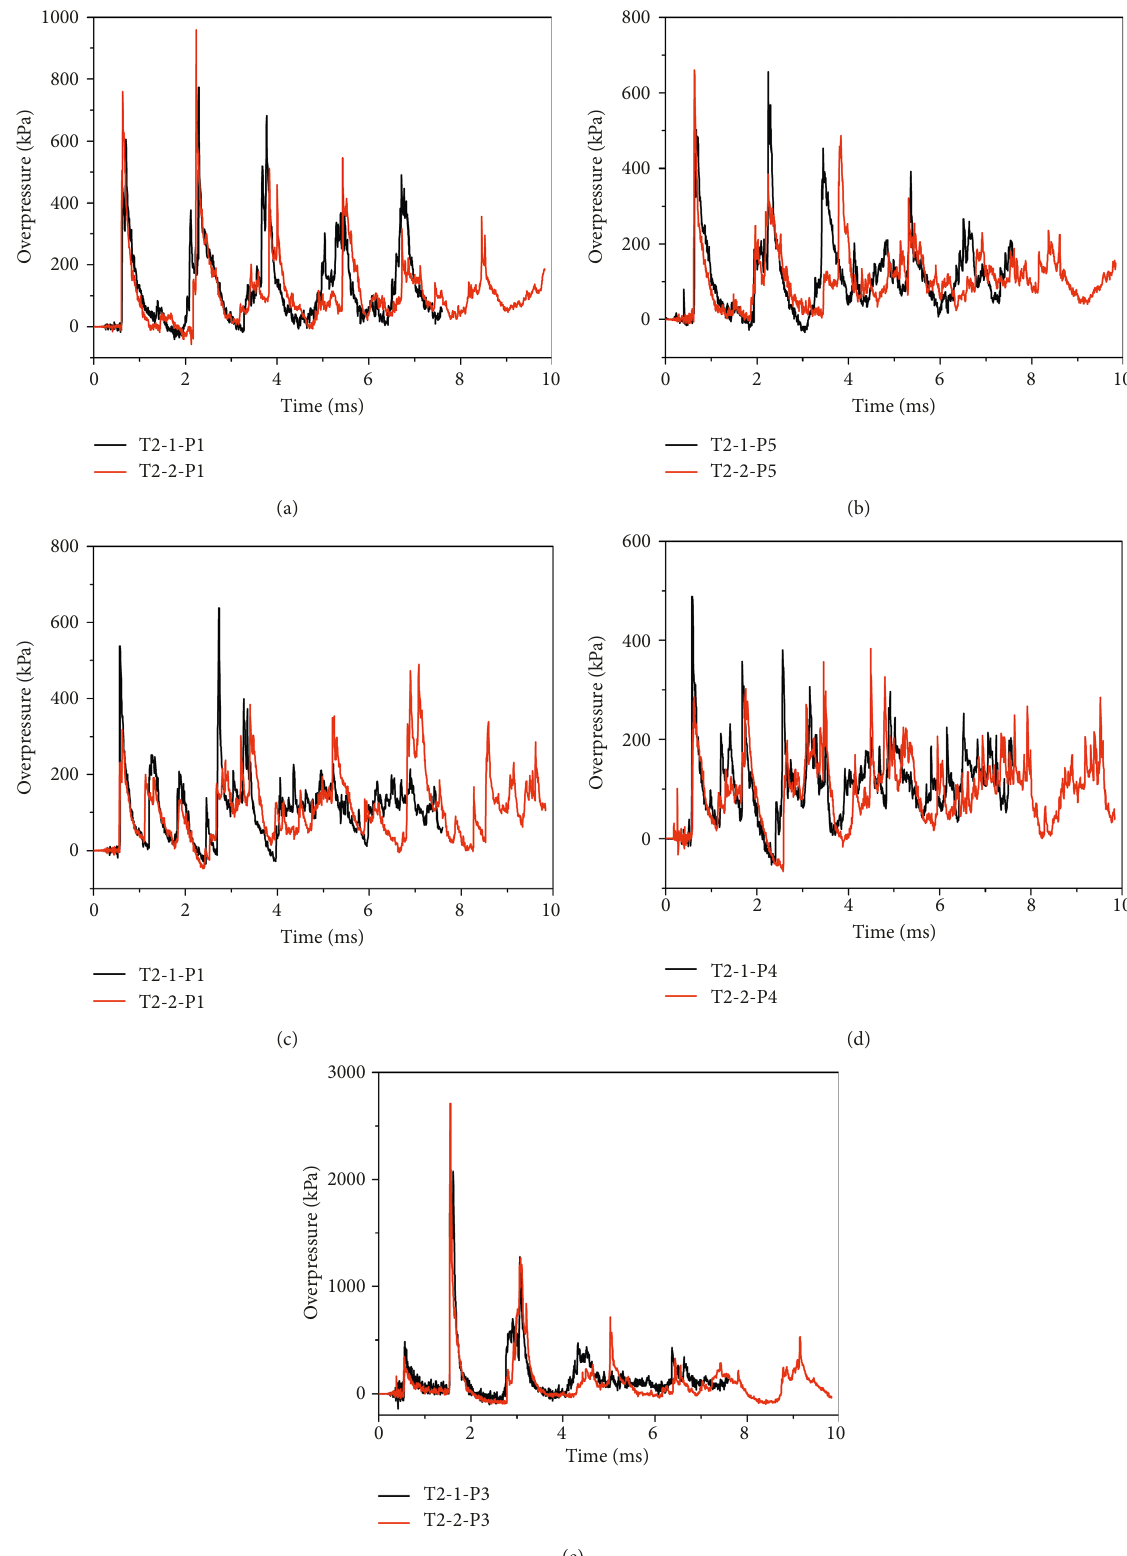
Figure 7: Experiment data from scenario T2 (13g TNT). (a) Test data from P1. (b) Test data from P5. (c) Test data from P2. (d) Test data from P4. (e) Test data from